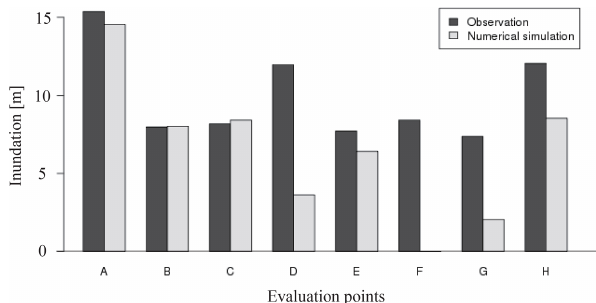
Figure 9. Comparison of inundation heights between observational data and simulation results (observation data are provided by the 2011 Tohoku Earthquake Tsunami Joint Survey Group,